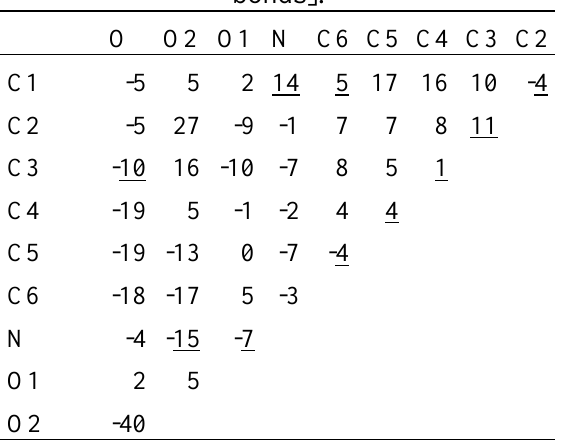
Table 1. Matrix for differences in MSDA’s ( mean square displacements of atoms) [Values listed are10 4 MSDA's for column atom minus that for row atom, underlined values correspond to chemical